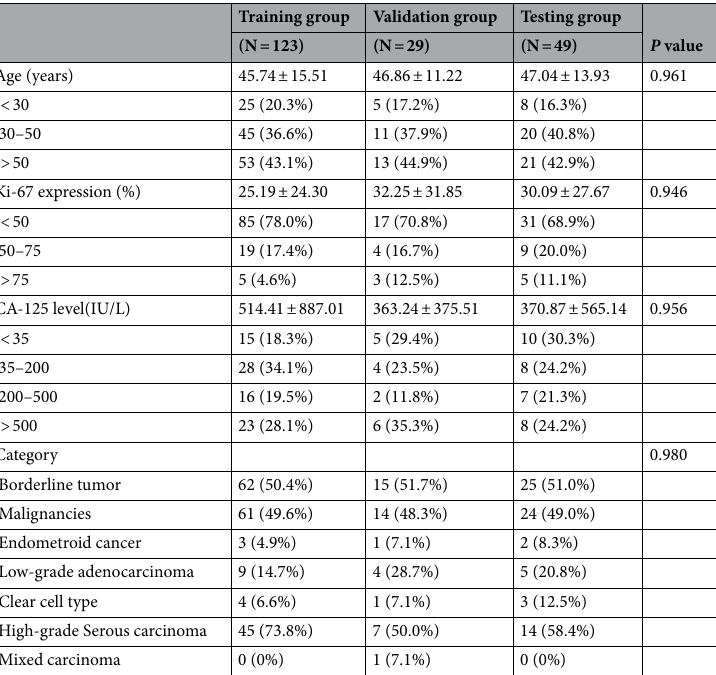
Table 2. Clinical and pathological data summaries in both training, validation and testing cohort.